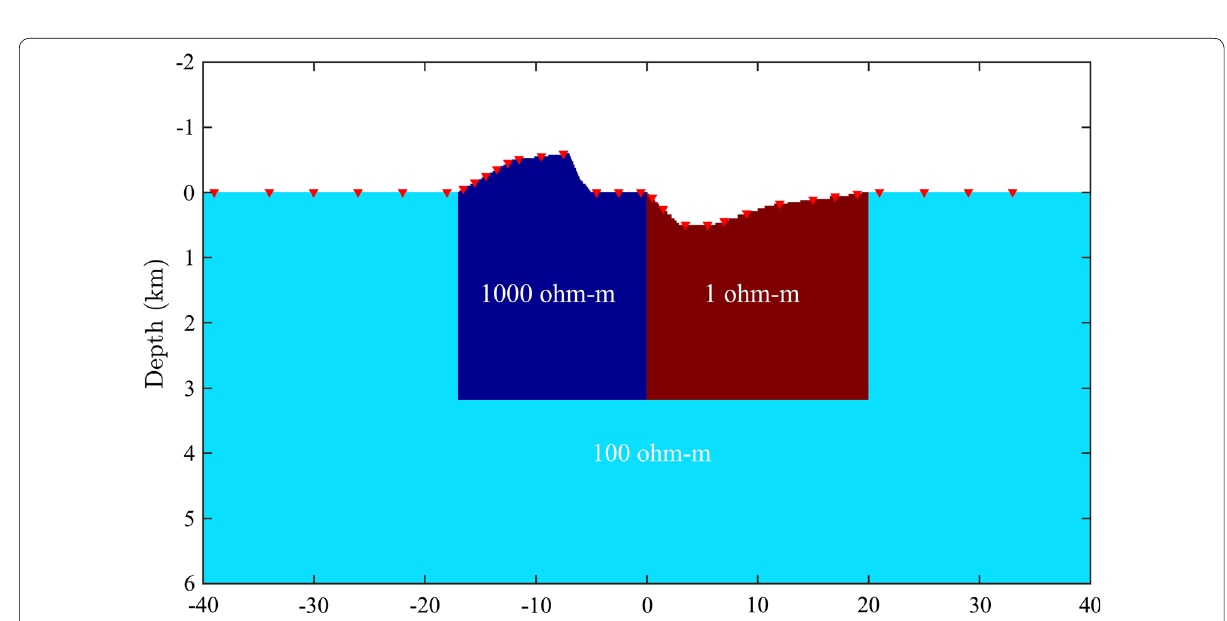
Fig. 8 Topographic model with mountain and valley (top). The sites marked as red triangles lie on the air–earth